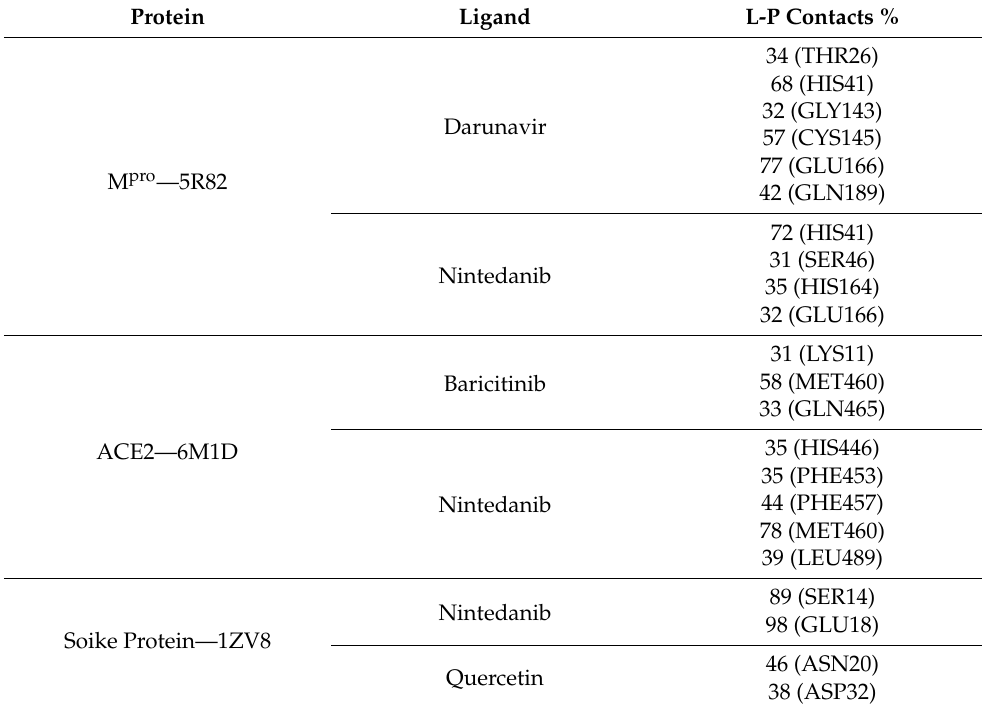
Table 4. Ligand-protein contacts exhibited during MD